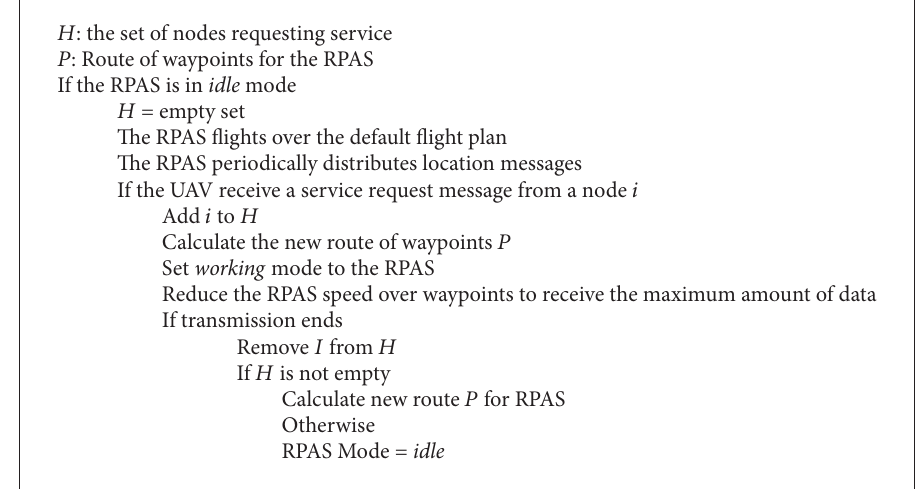
Algorithm 1: RPAS